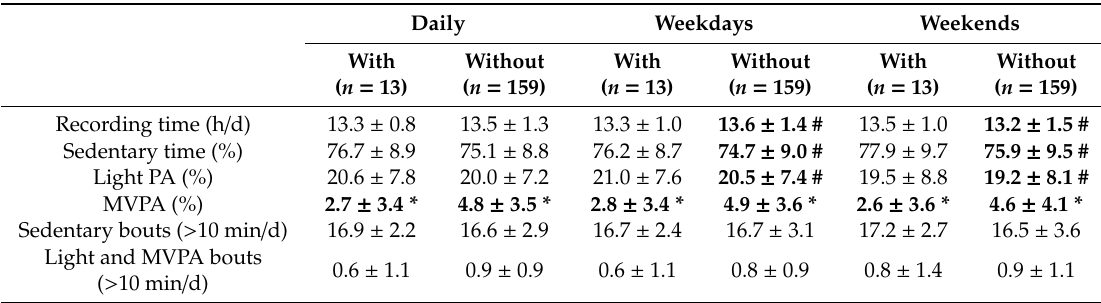
* Bold values indicate a significant di ff erence between with vs. without unmet PA need ( p < 0.05); # Bold values indicate a significant di ff erence between weekdays vs. weekends ( p <